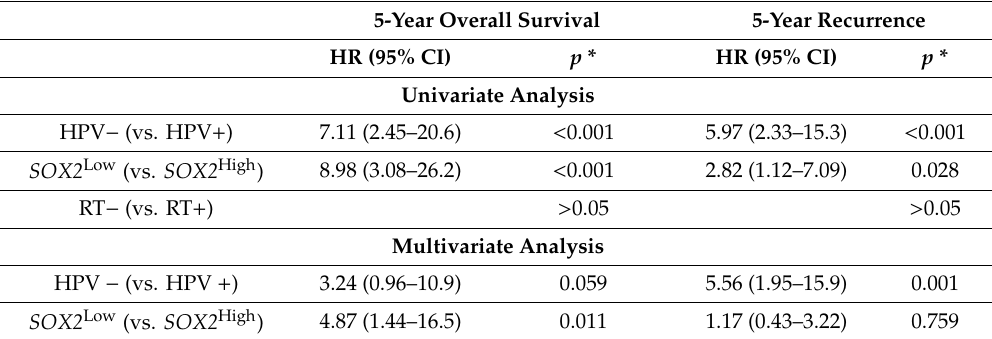
Table 4. Risk factor analysis for 5-year overall survival and recurrence in The Cancer Genome Atlas Head–Neck Squamous Cell Carcinoma (TCGA-HNSC)